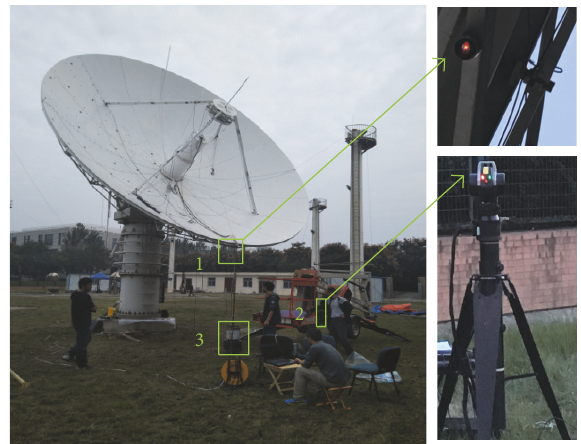
Figure 7: An example of field